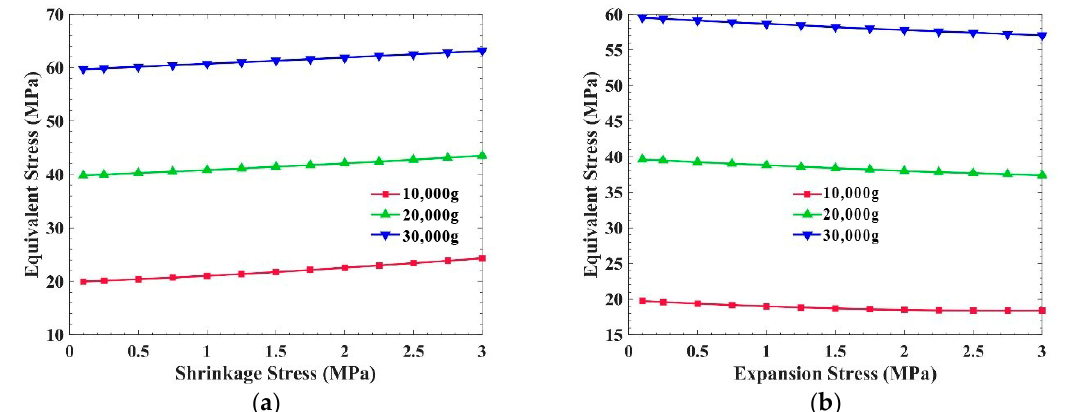
Figure 11. Influence of the different internal stresses of the potting adhesive on the equivalent stress of the metal frame: ( a ) Shrinkage stress; ( b ) Expansion stress.